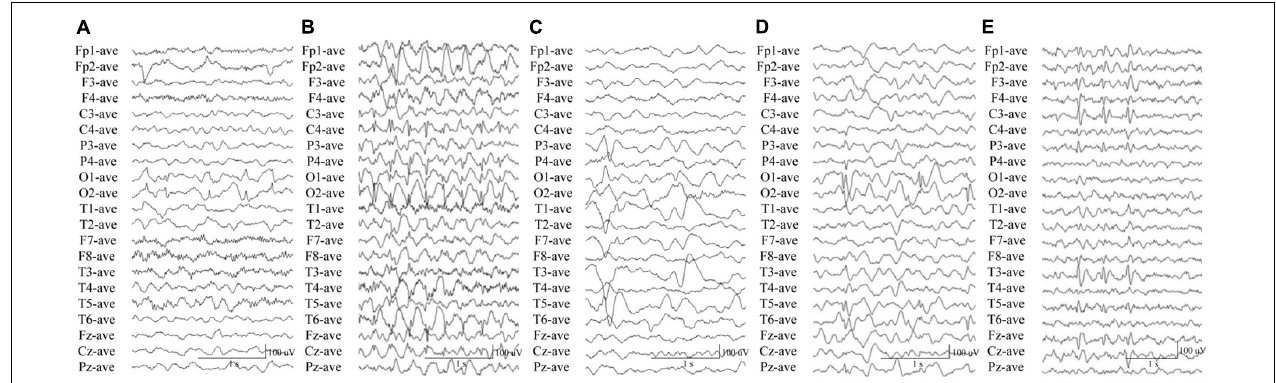
FIGURE 3 | Electroencephalography data of the cases with CACNA1A mutations. (A) Interictal EEG in case 2 showed bilateral occipital spike and slow waves. (B) Interictal EEG in case 4 showed generalized 3 Hz spike and slow waves. (C) Interictal EEG in case 6 showed left parietal and temporal sharp waves and focal spike and slow waves. (D) Interictal EEG in case 8 showed bilateral occipital spikes and focal spike and slow waves. (E) Interictal EEG in case 10 showed left parietal and temporal